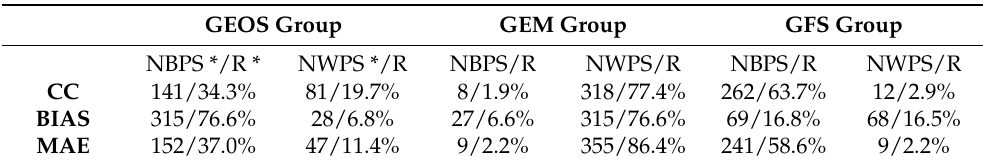
Table 3. Ranking statistics of wind speed forecast errors for the three ensemble forecast groups driven by the GFS, GEOS, and GEM model forecasts.